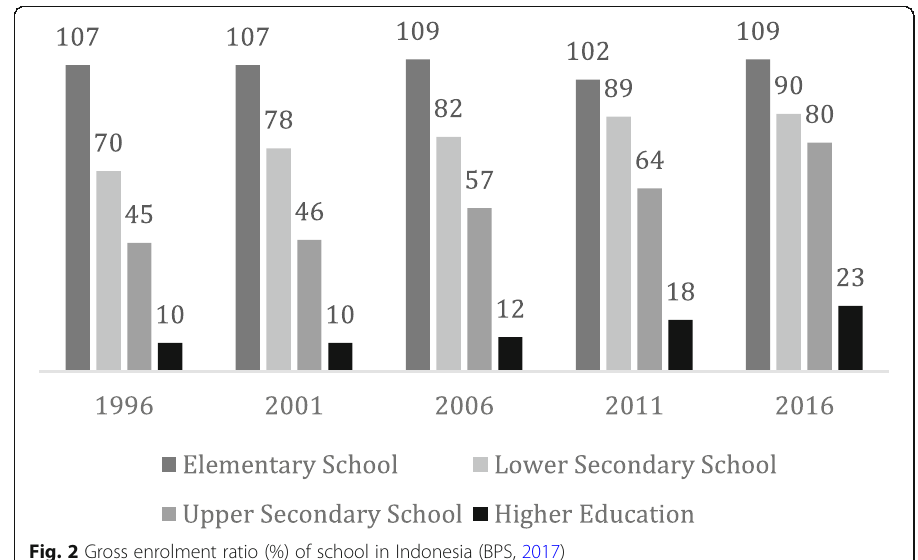
Fig. 2 Gross enrolment ratio (%) of school in Indonesia (BPS,